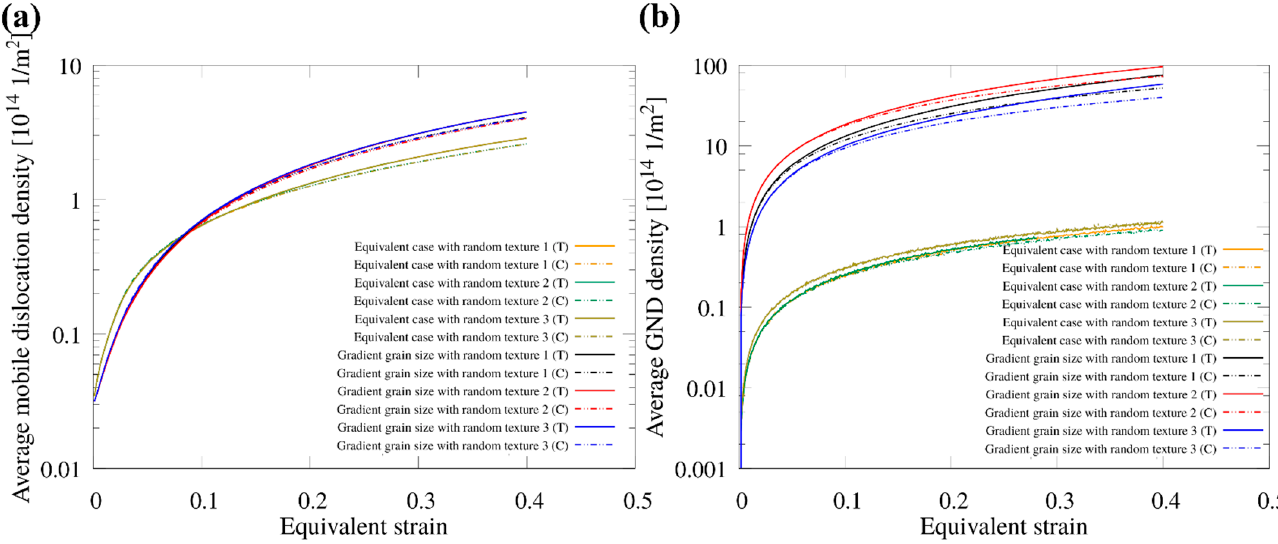
Figure 7. ( a ) Average mobile dislocation density vs. equivalent strain and ( b ) average GND density vs. equivalent strain, for IF specimens in tension and compression with three initial textures. Results are compared to samples with homogenous structures.